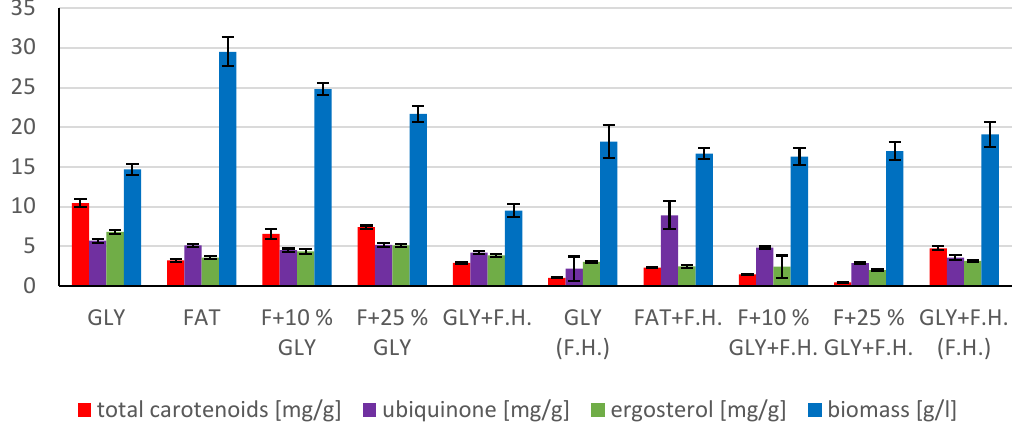
Figure 10. Metabolite production by biomass of yeast strain Rhodotorula mucilaginosa CCY19-4-25 in conditions of C/N ratio 25.